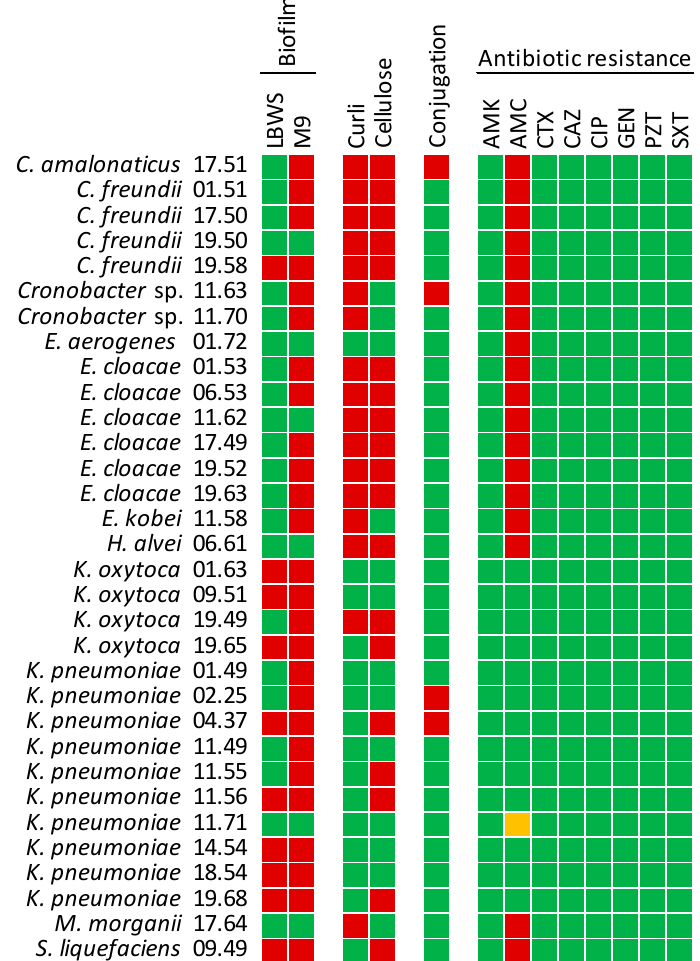
Figure 4. Phenotypic characterization of NECE isolates: biofilm formation in LBWS and M9 media, curli and cellulose production, conjugation, and antibiotic resistance. Colors: red, positive; green, negative. For antibiotics: red, resistant; green, susceptible, yellow, intermediate. Antibiotics: amikacin (AMK), amoxicillin–clavulanic acid (AMC), cefotaxime (CTX), ceftazidime (CAZ), ciprofloxacin (CIP), gentamicin (GEN), piperacillin-tazobactam (PZT), and trimethoprim-sulfamethoxazole (SXT).